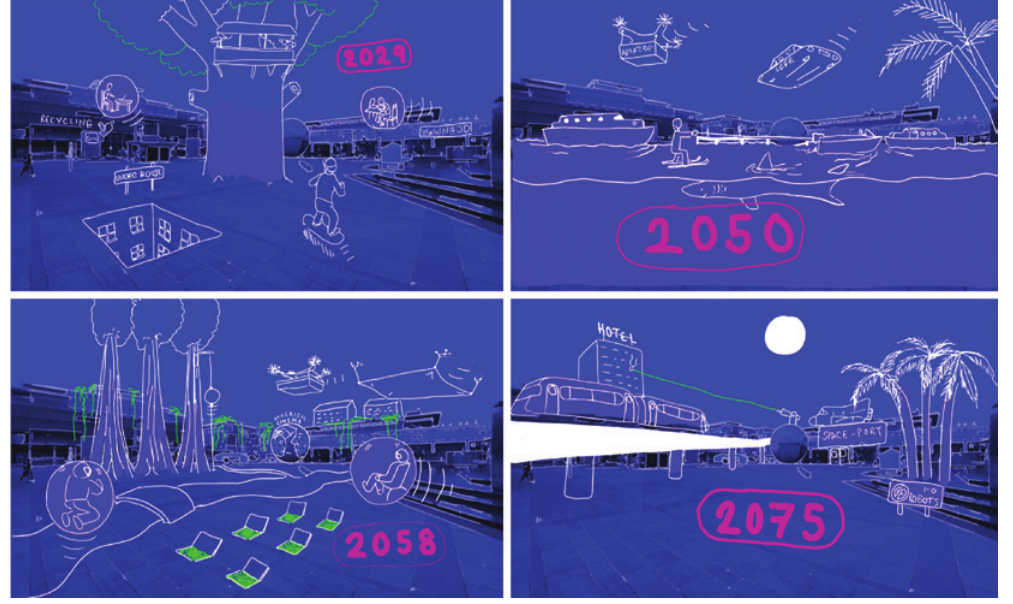
figure 4: example live illustrations by sam steer, from Billennium , Uninvited Guests and Duncan speakman, Layered Realities , Millennium square,